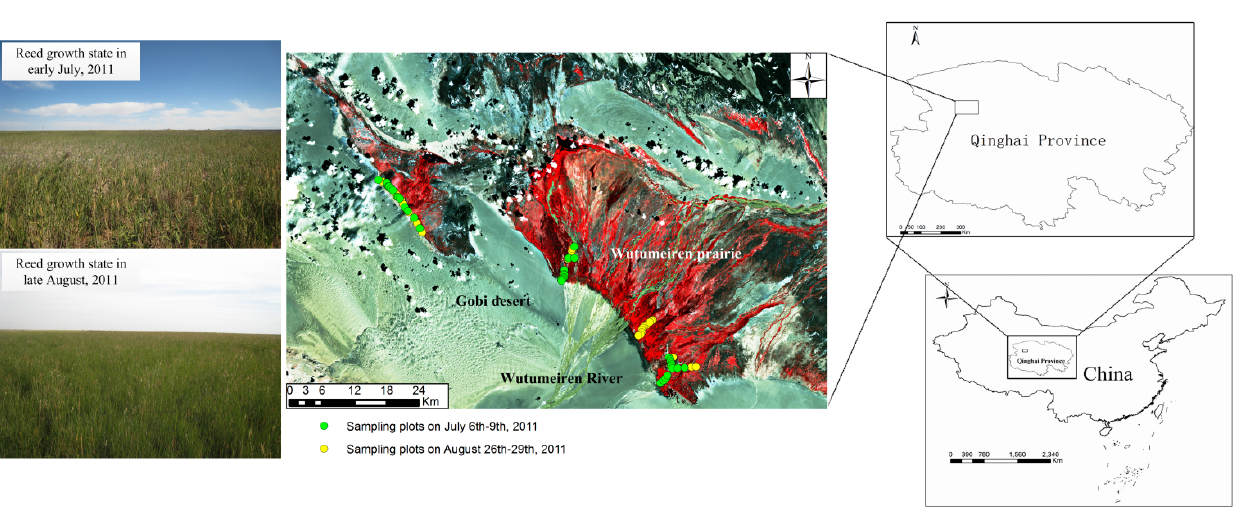
Figure 2. The study area (Wutumeiren prairie). The color composite Landsat5 image is TM4 (red), TM3 (green), and TM2 (blue). Green points represent the sampling plots from 6 to 9 July 2011, and the yellow points represent sampling plots between 26 and 29 August